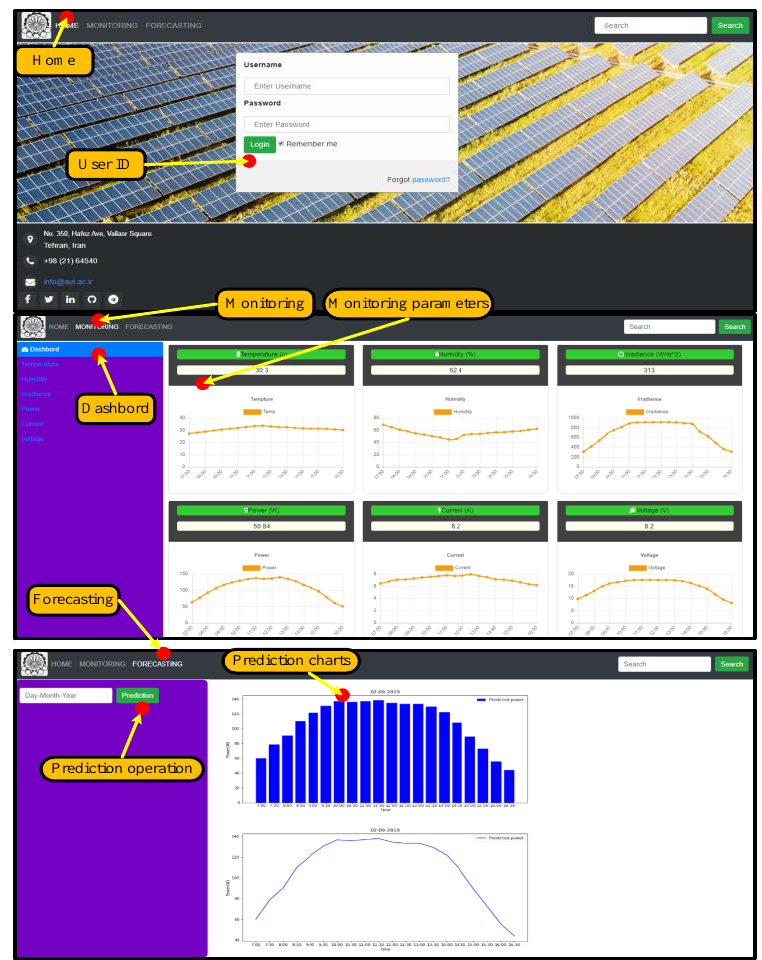
Figure 7. Display panel Intelligent Monitoring System (IMS).